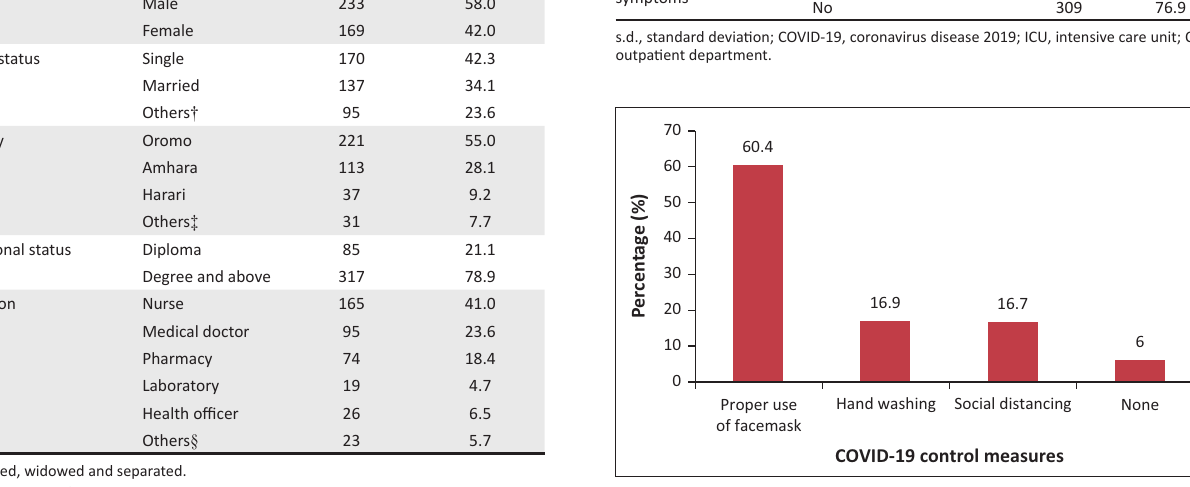
TABLE 1: Socio-demographic description of frontline healthcare workers during COVID-19 pandemic in Ethiopia, 2021 ( n = 402). Variables